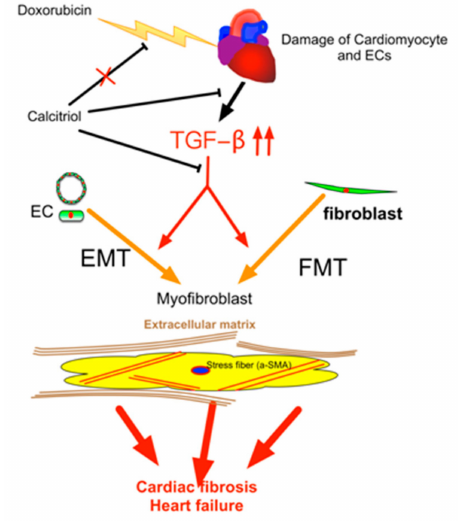
Figure 8. Schematic representation of the mechanism of action of calcitriol in the protection against DoIC-associated cardiac remodeling. Doxorubicin induced damage to cardiomyocytes and endothelial cells and caused subsequent tissue remodeling by the augmentation of the TGF- β pathway. Calcitriol attenuated Doxorubicin-caused cardiac remodeling by the attenuation of TGF- β -mediated EndMT and